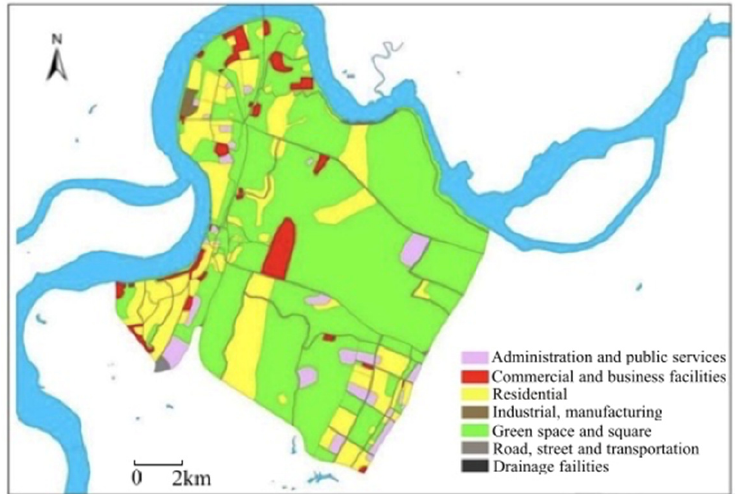
Figure 2. Land use and functional classification.